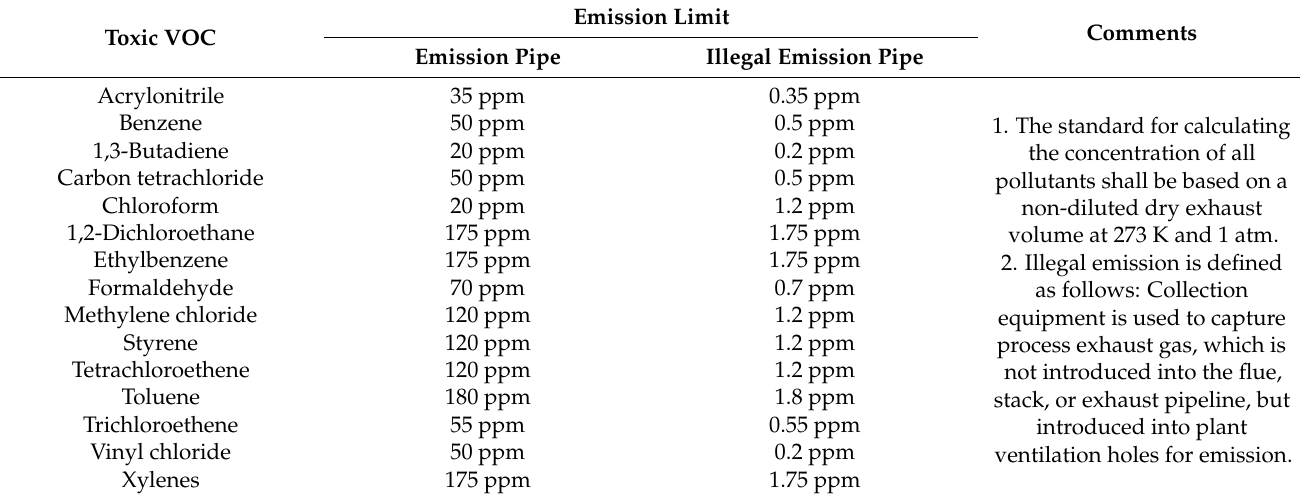
Table 4. Emission limits of toxic VOCs designated as HAPs in